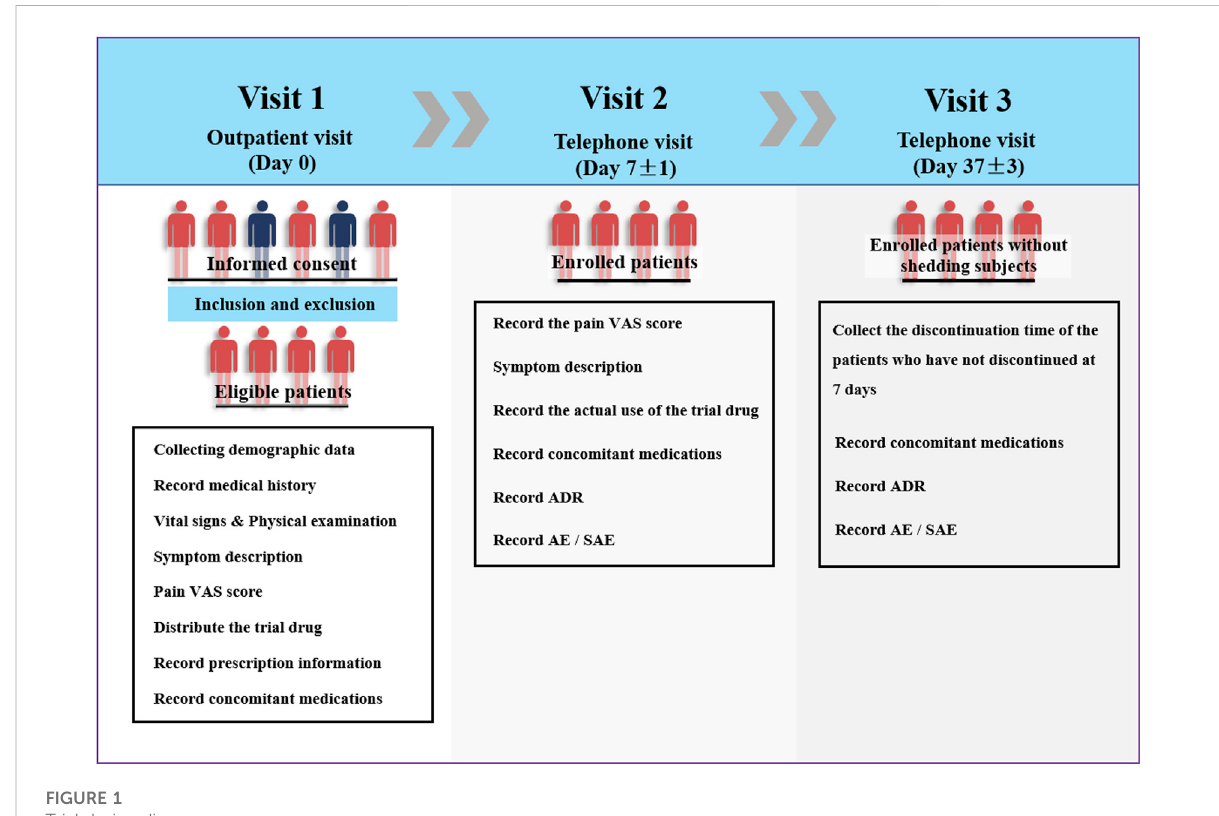
FIGURE 1 Trial design